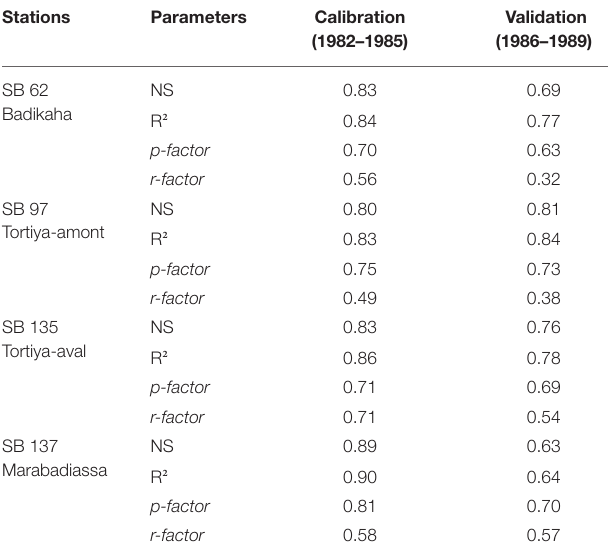
TABLE 3 | WBW model performance/robustness parameters during the calibration and validation periods.